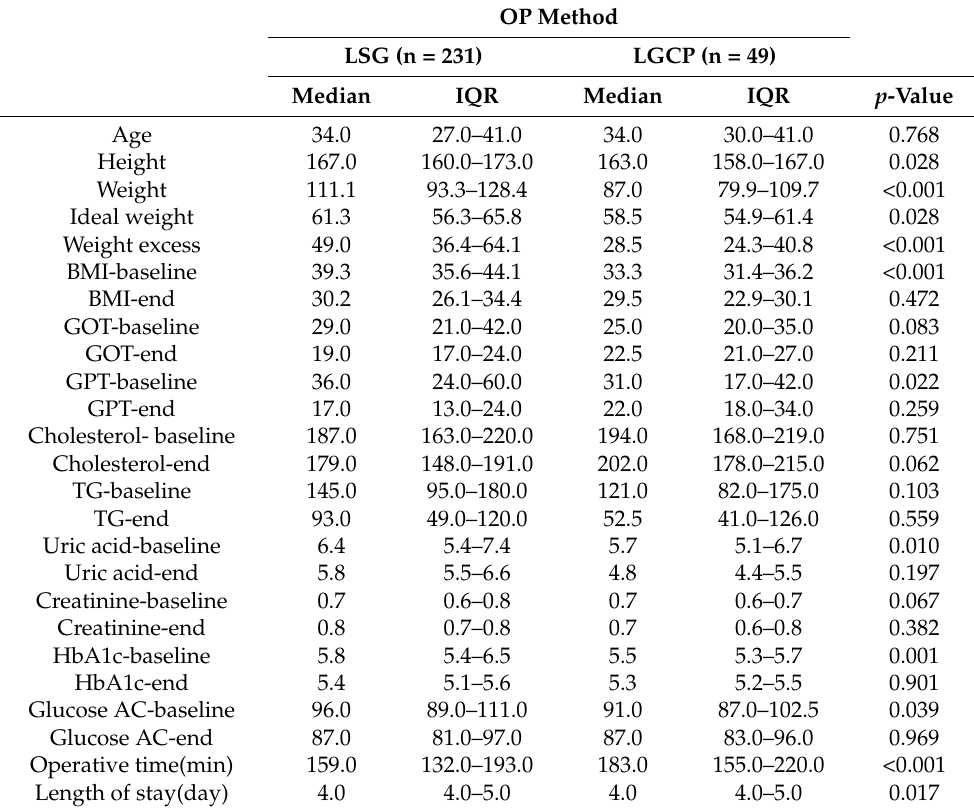
Table 1. Demographic description of the patients in this study.